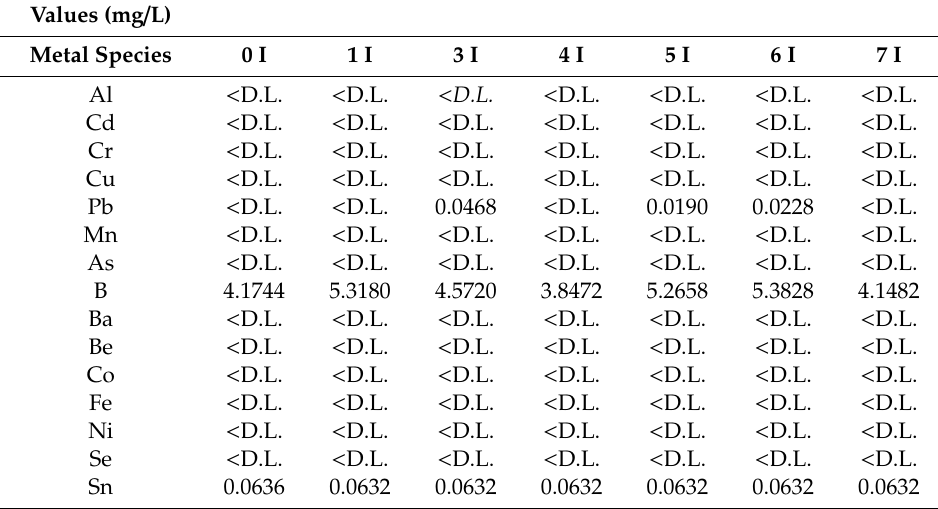
Table 4. Metal concentrations in water samples at Fontespina (mg / L). D.L. detection limit. Accuracy within the 95% confidence interval of the certified